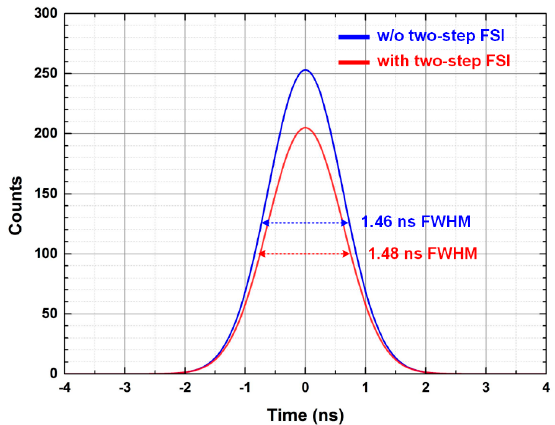
Figure 13. Measured timing spectra with and without the two-step FSI.